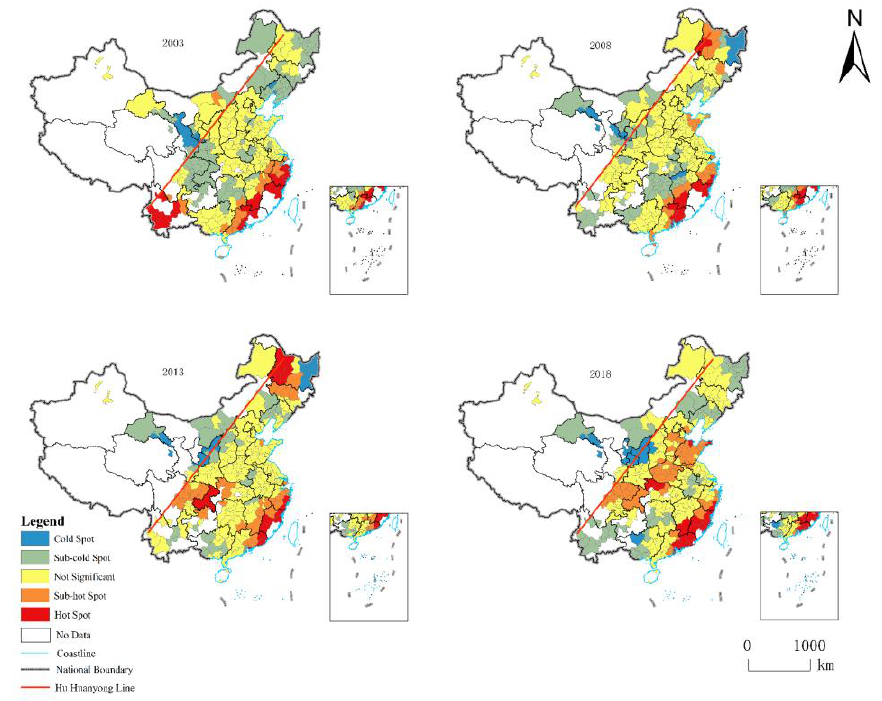
Figure 4. Analysis of urban cold hotspots in China, 2003 to 2018.